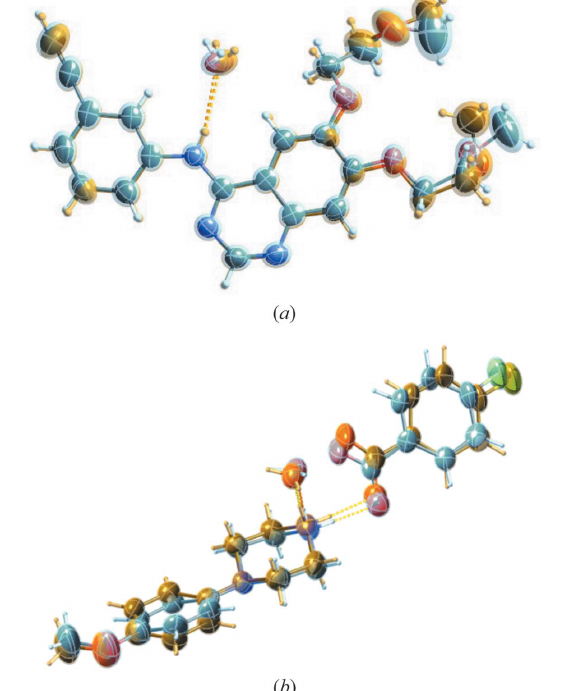
Figure 3 Displacement ellipsoid representations of the structure of erlotinib [CSD refcode DULKAX, ( a )], highlighting the almost perfectly overlaying atoms and the disordered parts of the different conformations of the molecules in the disordered structure, and the cocrystal structure of 4-(4- methoxyphenyl)piperazin-1-ium MeOPP 4-fluorobenzoate monohydrate [CSD refcode FOVPOY, ( b )]. The illustrations were generated with SHELXLE (Hu¨bschle et al. , 2011) using the restrained (DFIX/DANG) and additionally constrained (EADP) refinements I recommend.